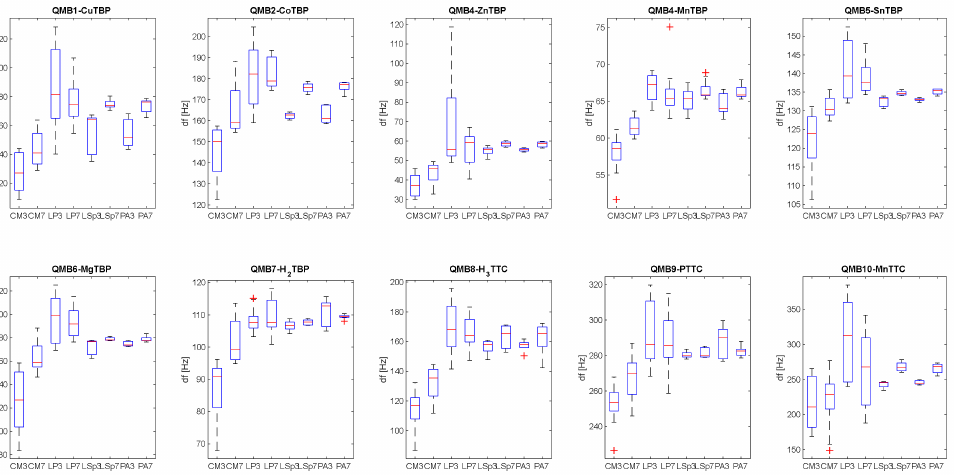
Figure 5. Boxplot representing the distribution of the sensor responses to control media (CM) and bacteria cultures: L. pneumophila (LP), Legionella species (LSp) and Pseudomonas aeruginosa (PA) considered after 3 (e.g., LP3) and 7 (e.g., LP7) days of